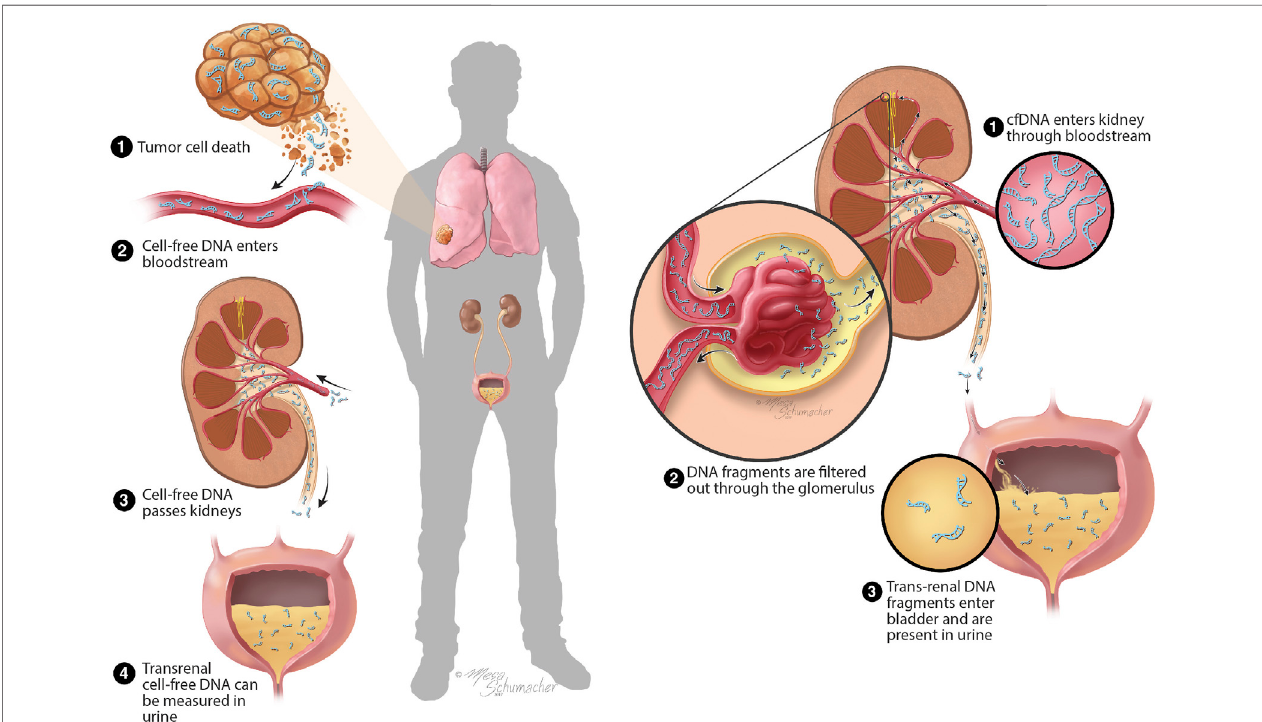
FIGURE 1 | Current model of formation of trans-renal ctDNA. The drawing on the left provides a conceptualized overview of the process of ctDNA generation and its transit to the urine. The drawing on the right provides a more detailed conceptualization of the presumed transit of cell-free DNA through the glomerular barrier of the kidney. Abbreviation used in the drawing: cfDNA, cell-free DNA. The artwork in this fi gure was created by Mesa Schumacher, M.A.